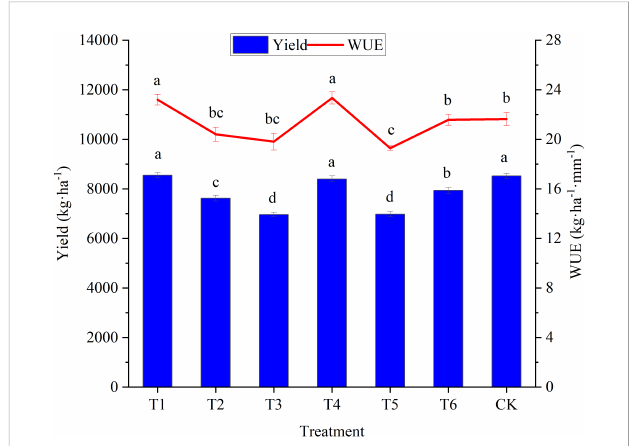
FIGURE 8 Response of yield and water use ef fi ciency in different water de fi cit treatments. Different lowercase letters mean the signi fi cant differences among treatments according to LSD ( P < 0.05). Data were presented as mean ± SE (n = 3).